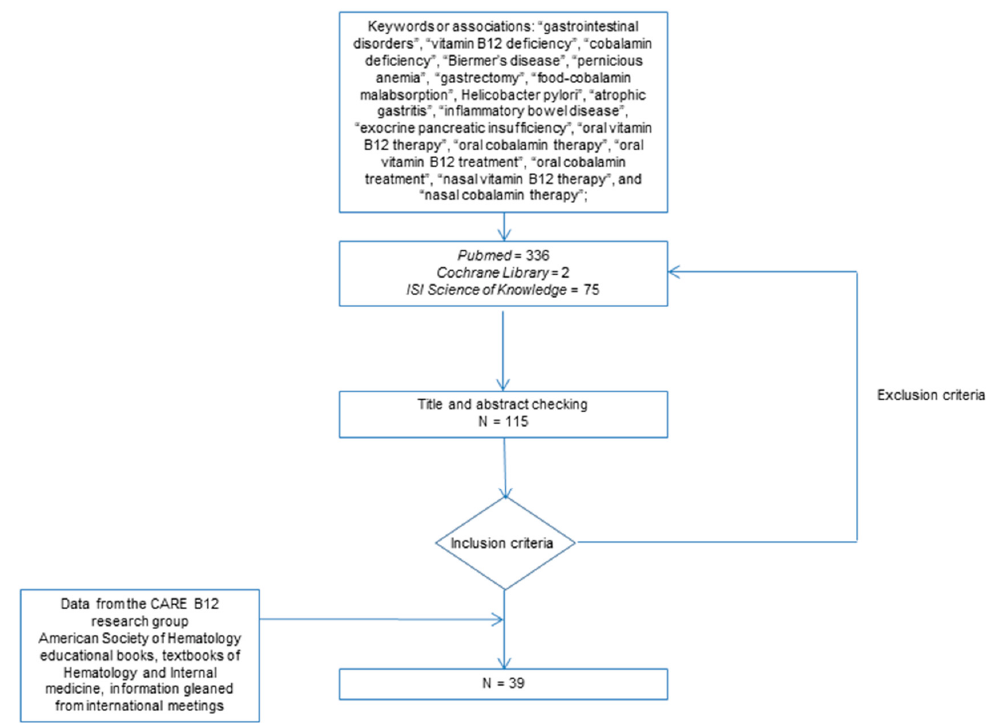
Figure 1. Flowchart of the reference research.